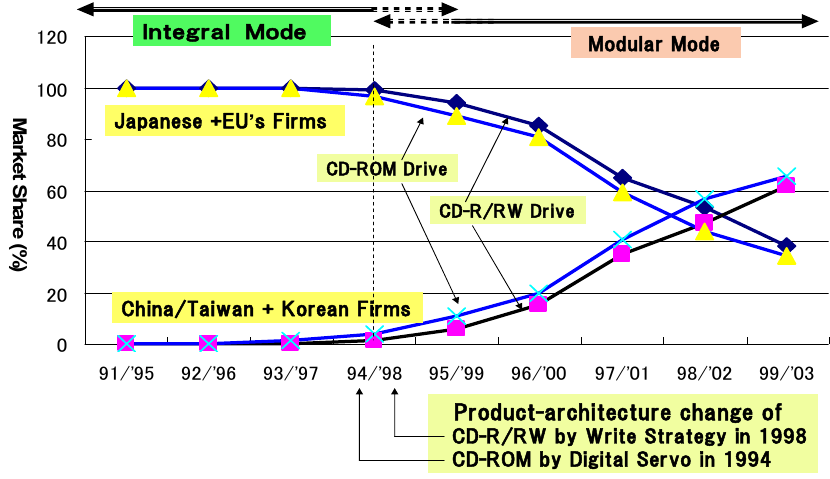
Figure 4. Effect of Product-architecture Change on Market Share by